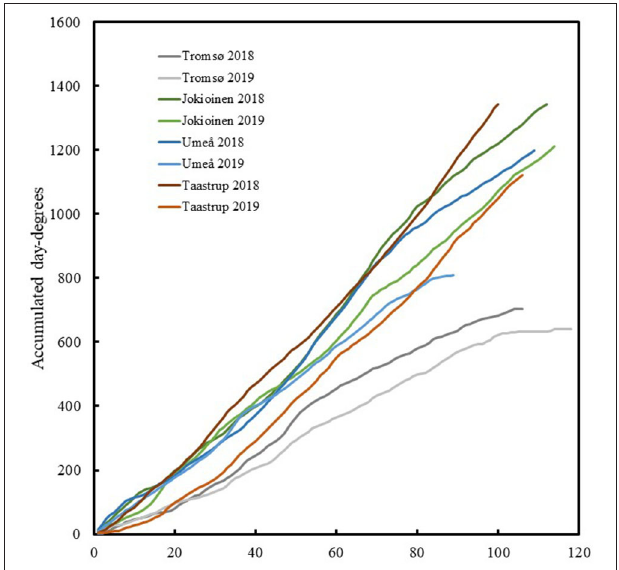
FIGURE 2 | The accumulated day degrees from date of sowing for different sites and